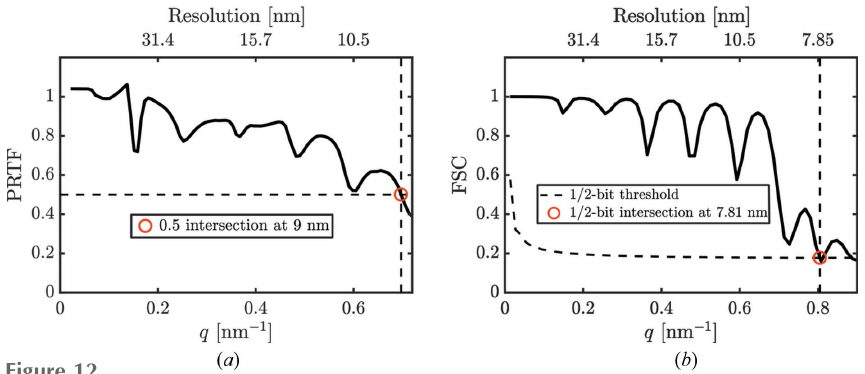
Figure 12 ( a ) Phase-retrieval transfer function (PRTF) and ( b ) Fourier-shell correlation (FSC) of data Set 7kPCA with background subtraction. Red dots correspond to the determined